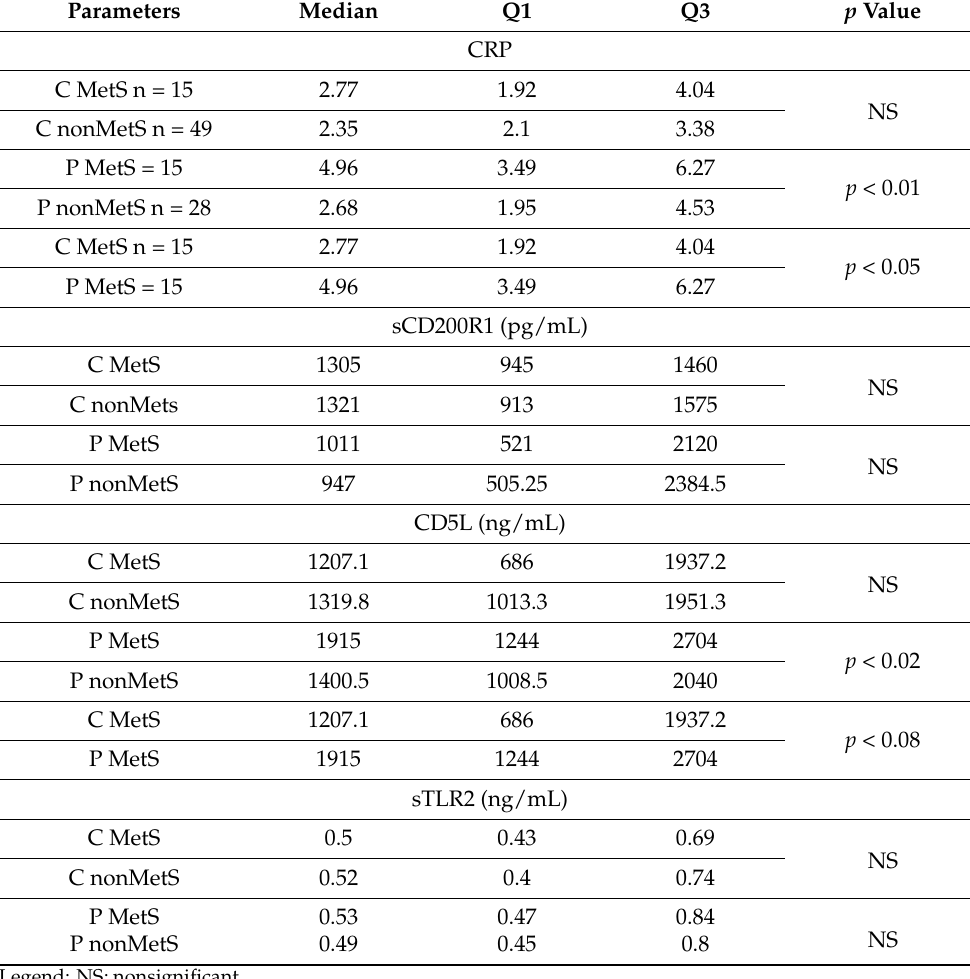
Table 5. The levels of selected markers in subgroups: controls without and with MetS; patients without and with MetS. Table 1. Demographic data.